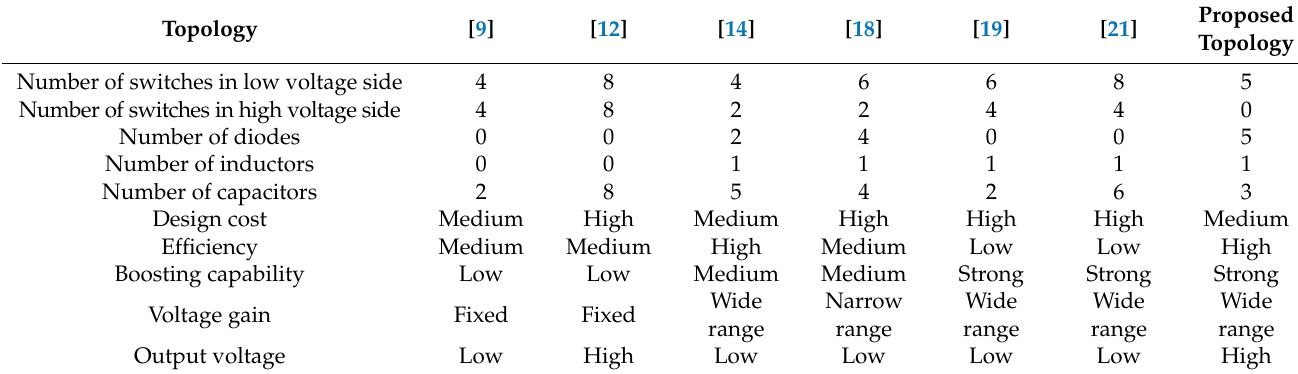
Table 1. Comparison between the proposed converter and other isolated converters.